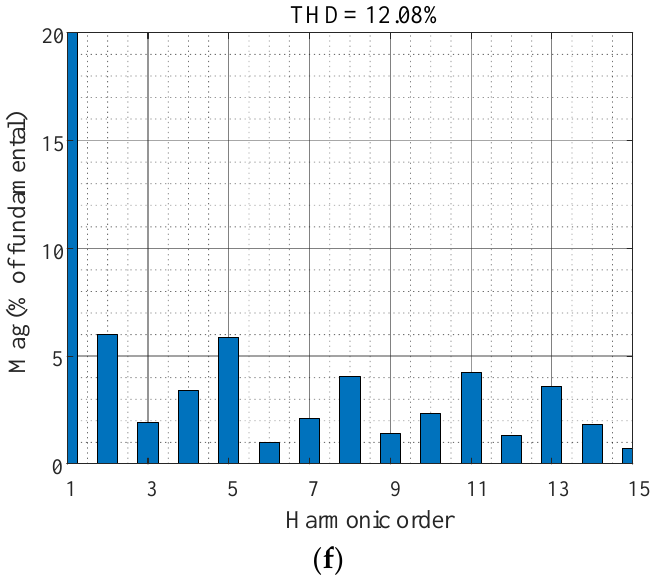
i with AN i with AN